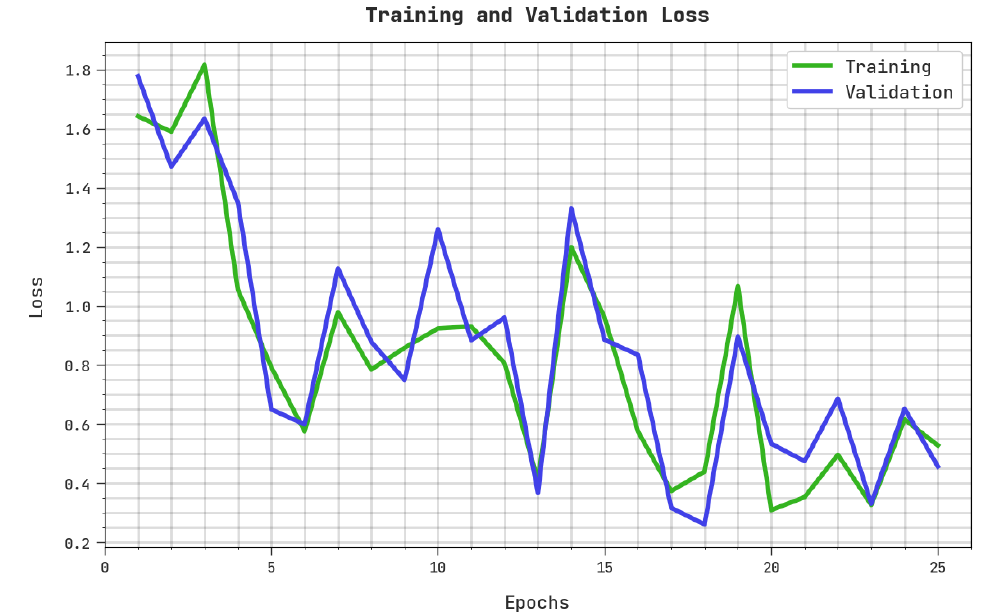
Figure 7. TRL and VLL analysis ASODCAE-SLR approach.